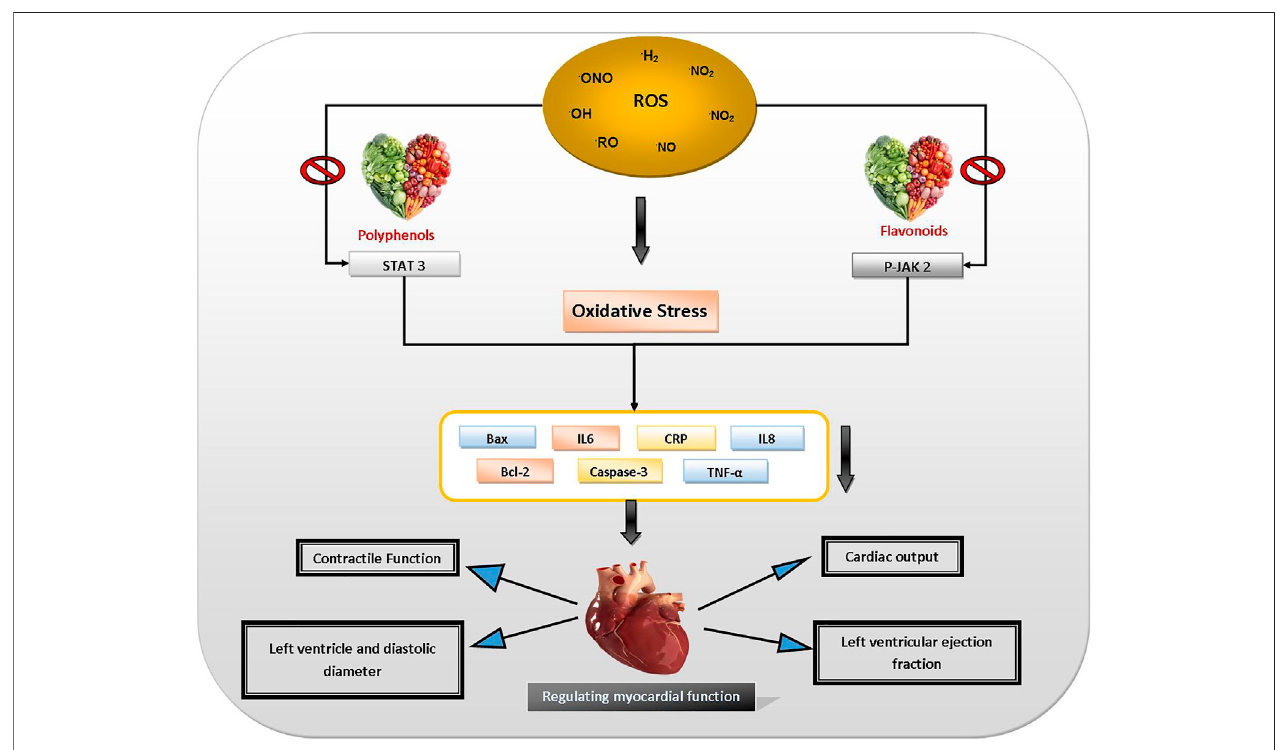
FIGURE6| ProtectiveeffectsofdietarypolyphenolsagainstCVDs.Abbreviations:Bax:BCL2associatedXapoptosisregulator,IL6:interleukin 6,CRP:C-reactive protein, IL8: interleukin 8, Bcl-2: B-cell lymphoma 2, Caspase-3: cysteine-aspartic acid protease 3, TNF-alpha: tumour necrosis factor - alpha, P-JAK 2: protein Janus kinase 2, STAT 3: signal transducer and activator of transcription 3